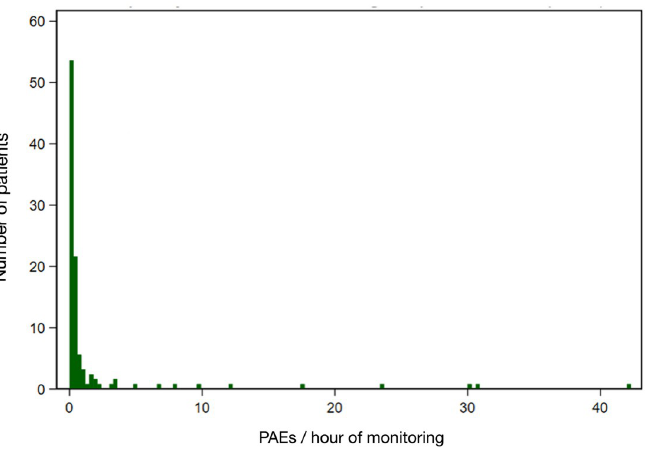
AI, ODI, IPI, and SpO . The proportion of recorded time of deranged AI, ODI, IPI, and 2 SpO is described in Fig 3 and is expressed as average minutes per hour of monitoring. AI and 2 ODI were deranged (i.e., � 5 events/hour) for every hour of monitoring for up to 18.1 minutes and 18.9 minutes, respectively, in at least half of all patients (Fig 3A and 3B). The duration of deranged IPI that met the threshold for requiring attention (IPI � 7) was up to 6.9 minutes for